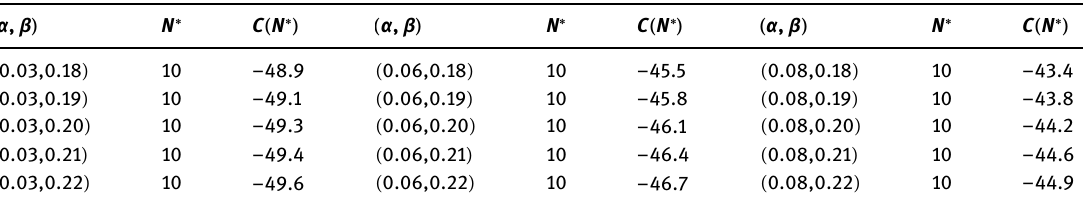
Table 2: The expected